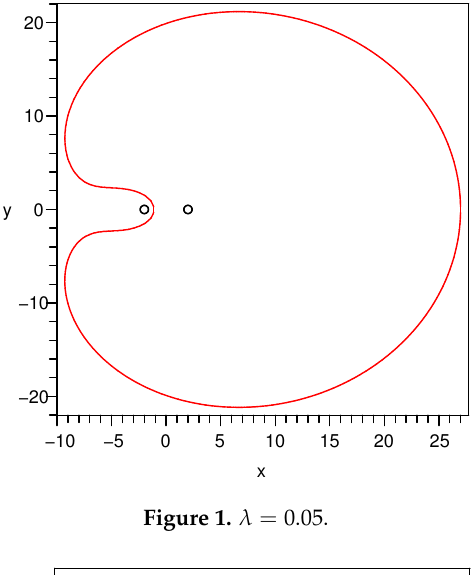
Figure 1. λ = 0.05.